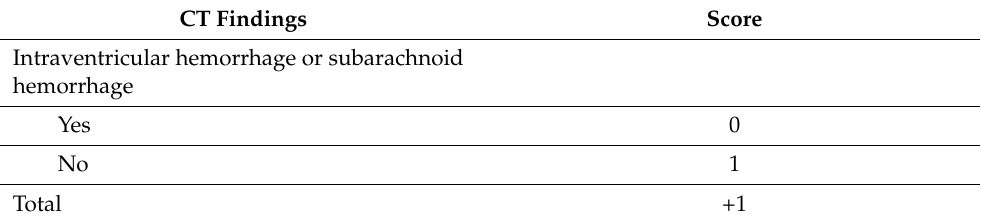
Table 1. Cont. CT Findings Score Intraventricular hemorrhage or subarachnoid